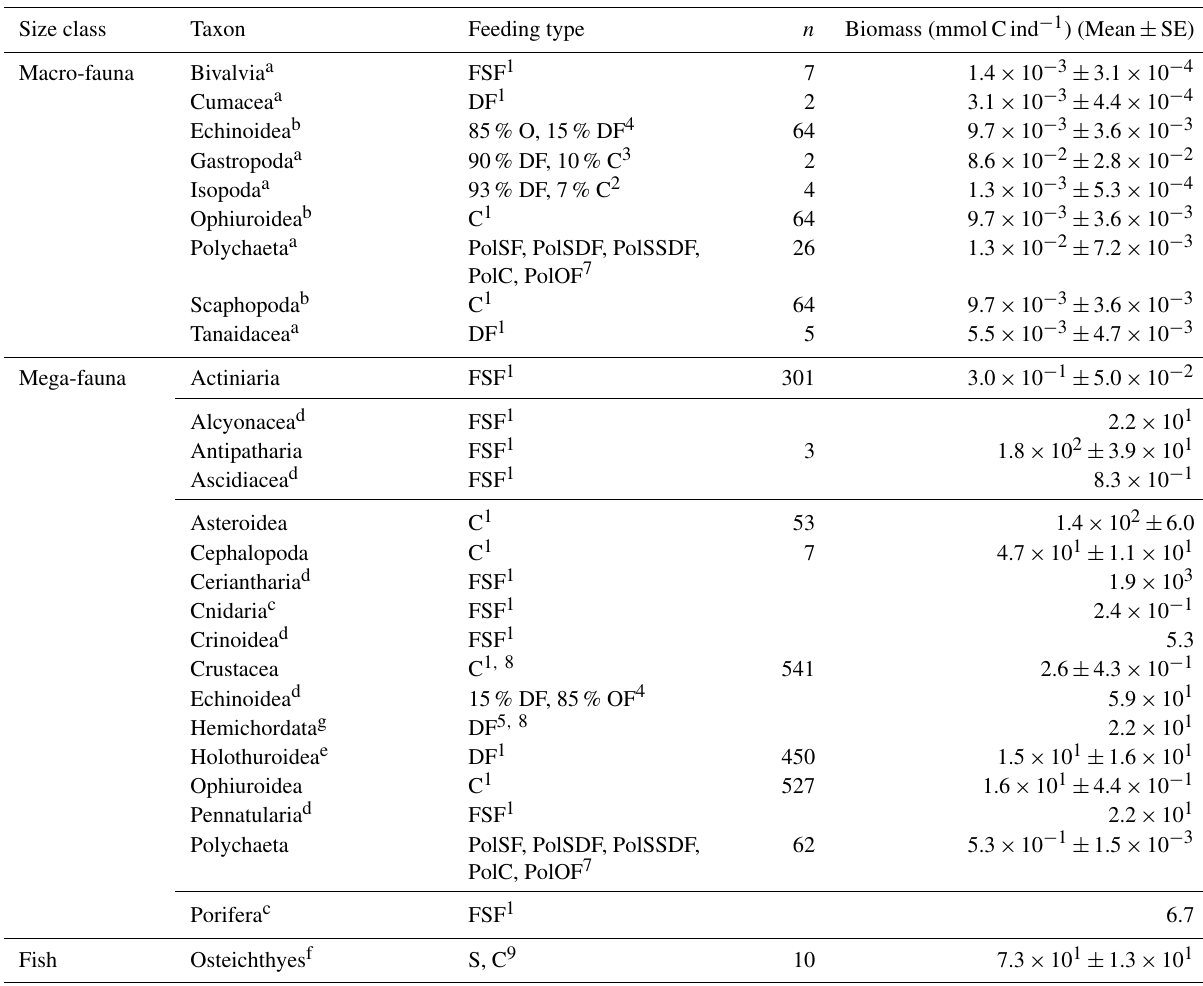
a Taxon-specific individual biomass; b Individual biomass calculated based on all other macrofauna data; c Median taxon-specific individual biomass for individuals from the Porcupine Abyssal Plain where Durden et al. (2016) did not have reliable dimension measurements; d Mean taxon-specific biomass data per individual were extracted from Tilot (1992) for the CCZ; e Individual biomass of Benthodytes sp., one of the most abundant holothurian morphotype at the DISCOL site (Stratmann et al., 2018b); f Individual biomass of Ipnops sp., the most abundant deep-sea fish at the PD g Individual biomass calculated for mean benthic invertebrate 26 outside plough tracks; megafauna at 4100m depth based on the biomass-bathymetry and abundance-bathymetry relationships presented in Rex et al.